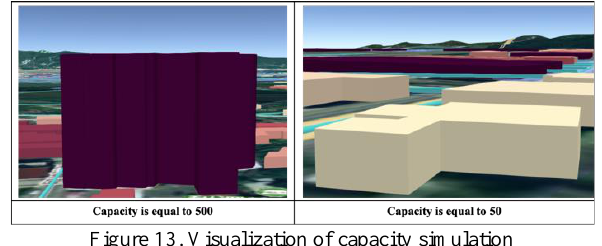
Figure 15. Evacuation visualization combining with the closest facilities analysis